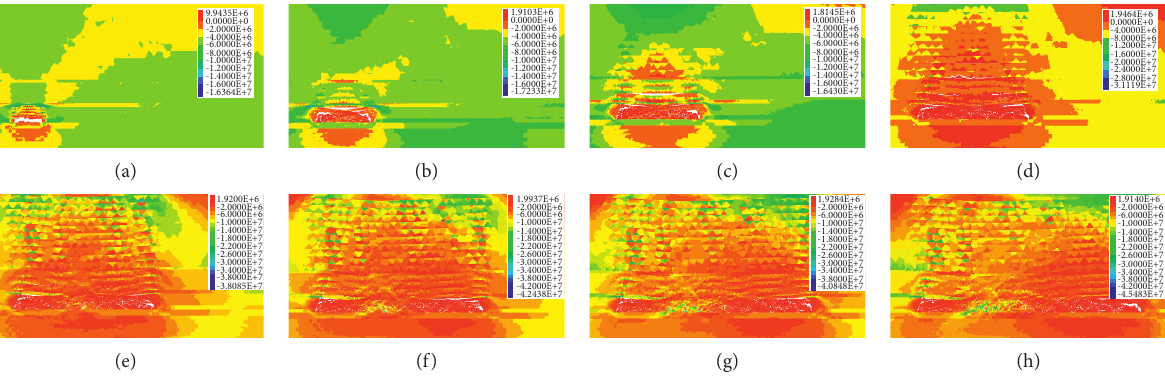
Figure 8: Horizontal stress distributions around the mined-out area. (a) Stage 1 (20m). (b) Stage 2 (40m). (c) Stage 5 (60m). (d) Stage 4 (80m). (e) Stage 5 (100m). (f) Stage 6 (120 m). (g) Stage 7 (140m). (h) Stage 8